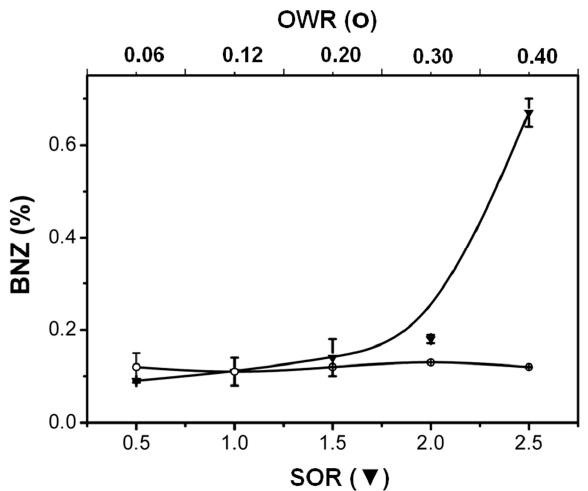
Figure 6. BNZ loading as a function of the surfactant-to-oil ratio (SOR) or oil-to-water ratio (OWR). Note: data are expressed as the mean ± SD ( n =